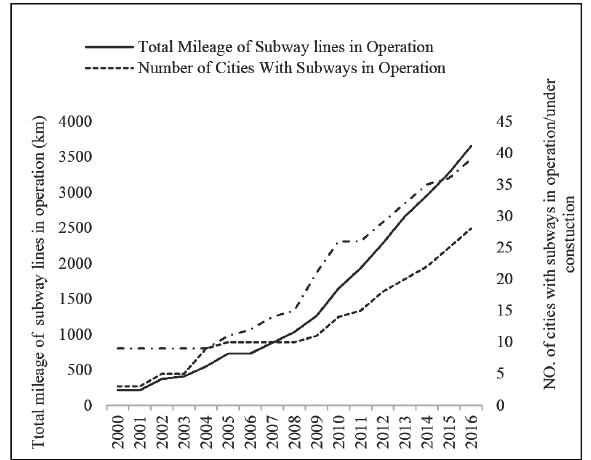
Figure 1. Subways coming into service in Mainland China from 2000 to